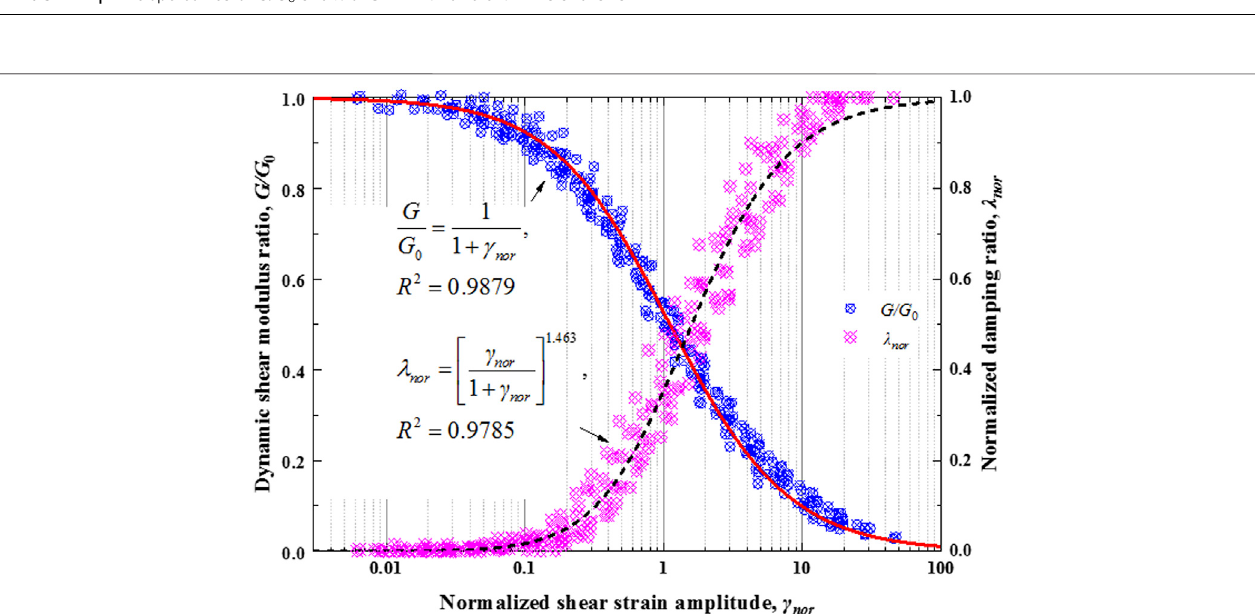
FIGURE 3 | G/G 0 and normalized λ of SRM with γ nor